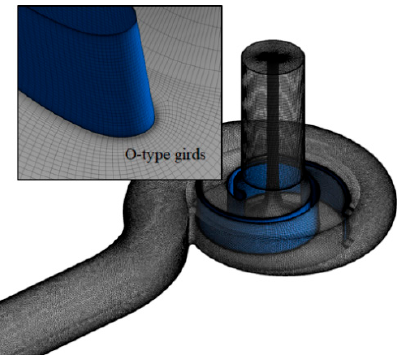
Figure 3. Grid systems of the two-vane pump.